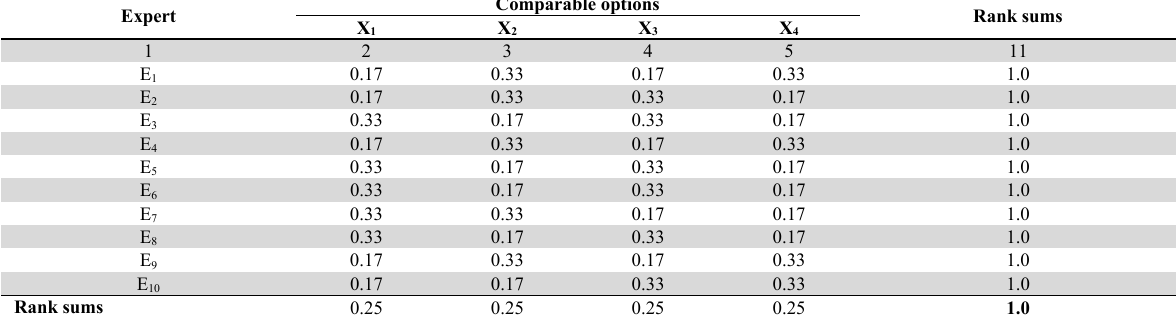
According to expert estimates, the weight scale of the components of the studied enterprise performance indicators by the priority level was distributed proportionally equally − 0.25. This situation is most likely due to the fact that all efficiency indicators participate equally in the calculation of the formation of the efficiency indicator of the enterprise. To inform the decision on the need to adjust the performance of the entity whose reporting is verified, the assessment of the importance of each component of efficiency for the enterprise, by determining the coefficient of significance (Table 8). Priority level evaluation of the main components of the studied enterprise efficiency The level of importance for the enterprise 1